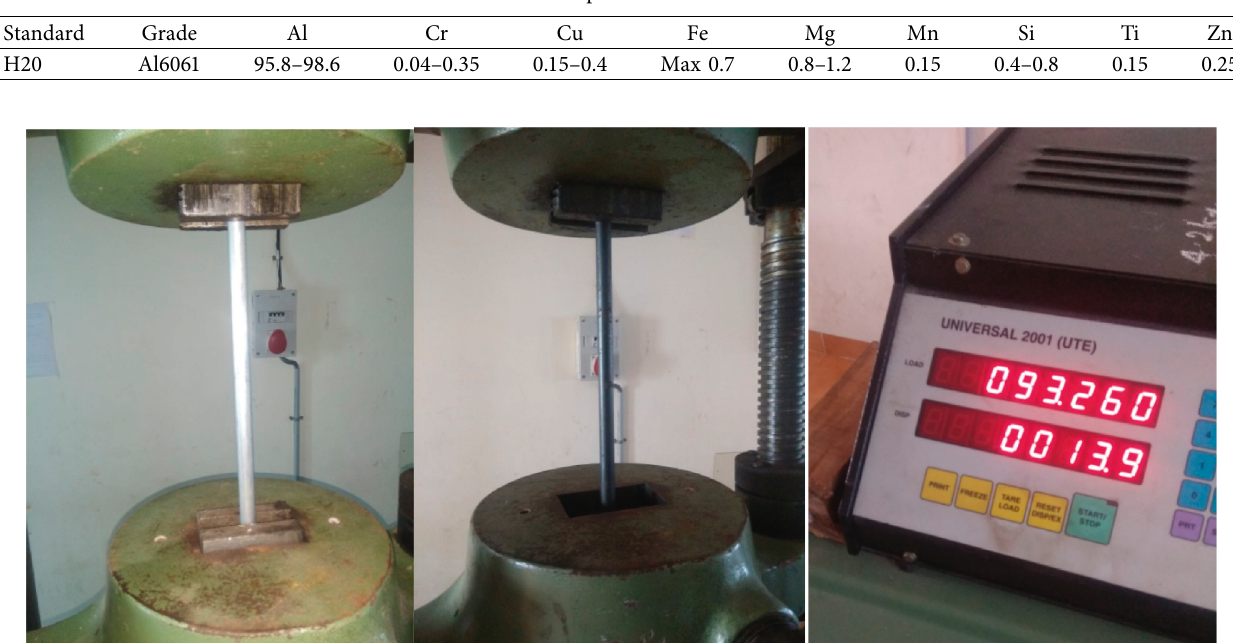
Table 2: Chemical composition of aluminum 6061-T6.